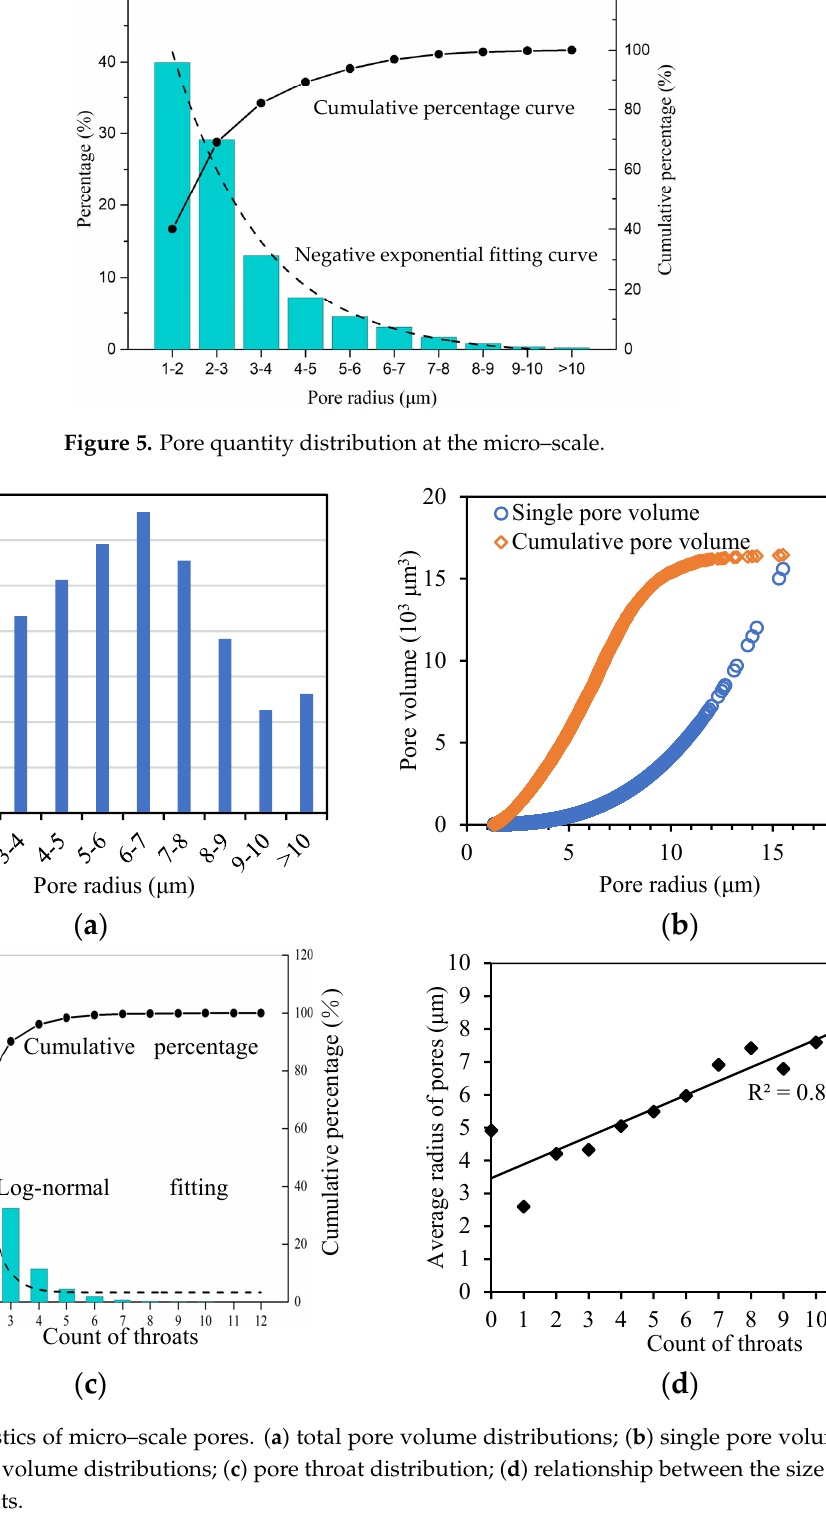
Figure 6. Characteristics of micro–scale pores. ( a ) total pore volume distributions; ( b ) single pore volume distributions and cumulative pore volume distributions; ( c ) pore throat distribution; ( d ) relationship between the size of pores and the number of pore throats.